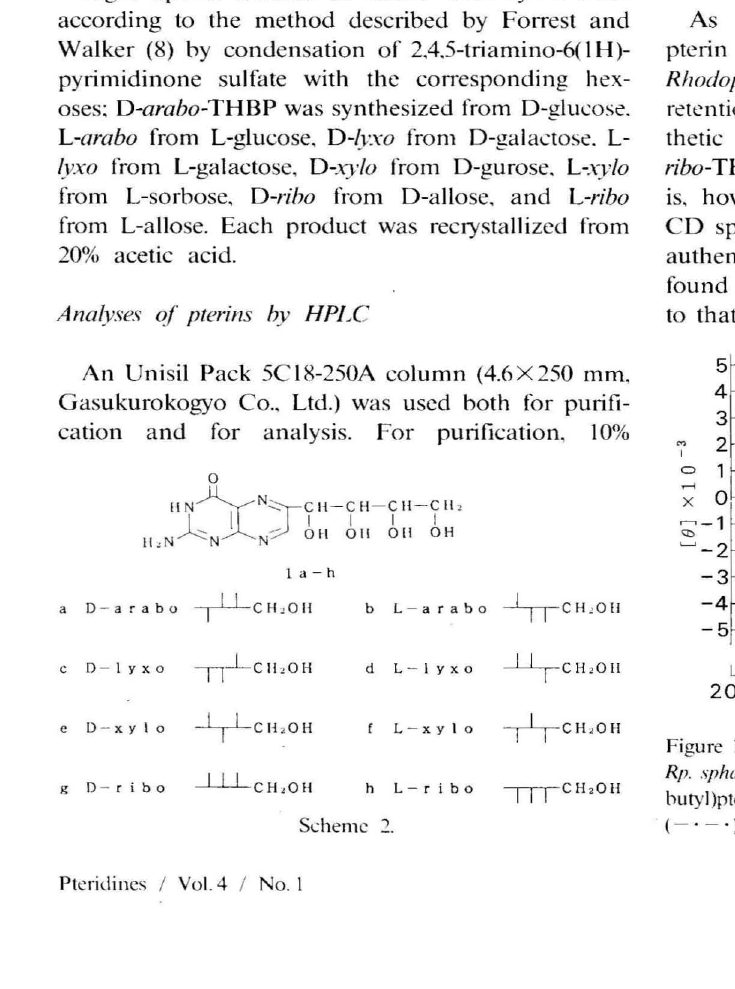
Figure I. CD spectra of 6-( 1.2JA-tctrahydroxyhlltyl)pterin from Rp . . Iphaeroide.l' (- ) and synthetic 6-(D-n·ho-I.2.3A-tetrahydroxy hlltyl)pterin ( ... ) and